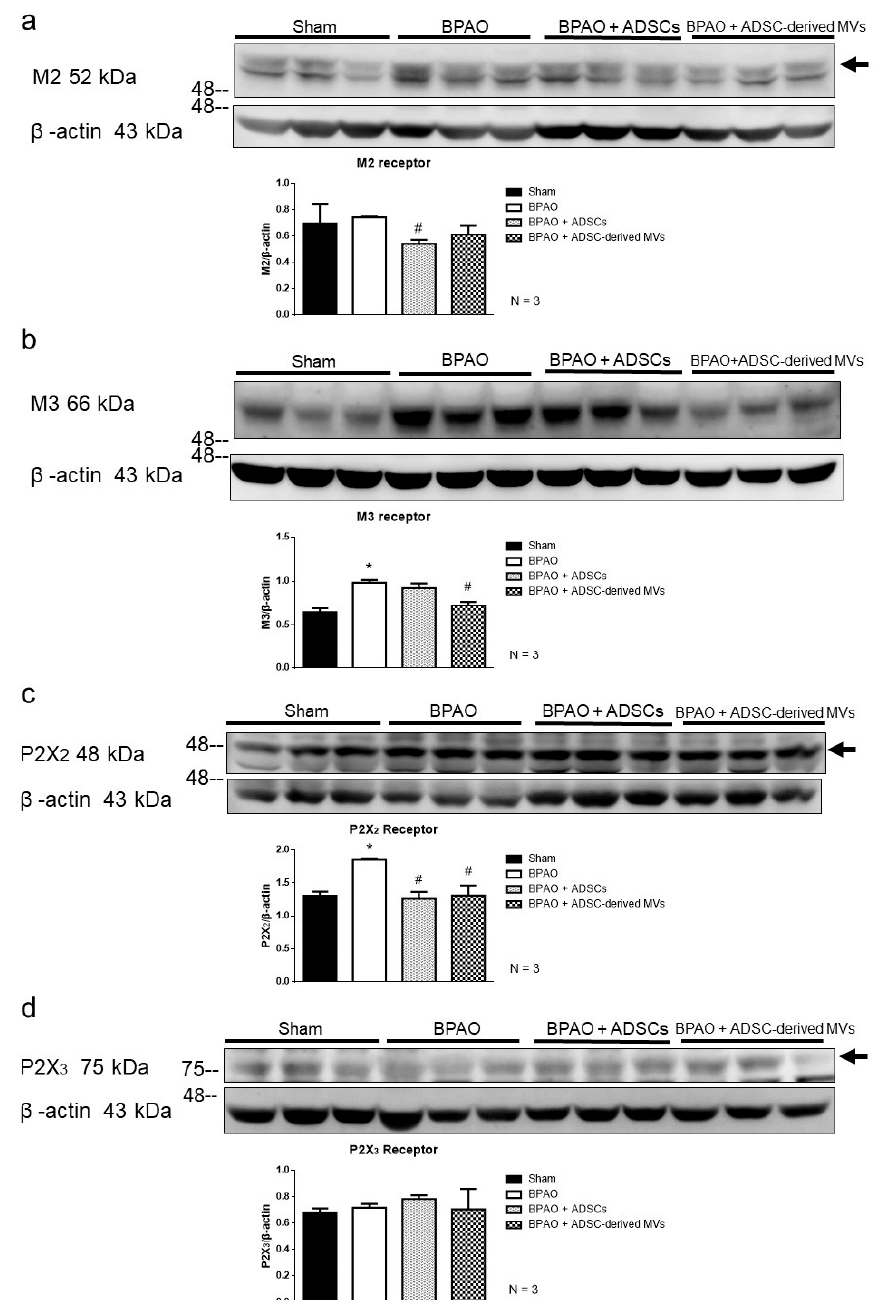
Figure 7. Purinergic and muscarinic signaling associated molecules changes on western blot study in separated group. Figure 7 showed the expression of muscarinic cholinergic (M2 and M3) and purinergic receptor proteins (P2X2 and P2X3) by Western blot. In the top panel, ( a ) showed the expression of M2 receptor is significantly decreased in BPAO + ADSCs group compared to BAPO group ( # p < 0.05). The expression of M2 receptor had trend of decreasing in BPAO + ADSC-derived MVs group compared to BAPO group without significant differences ( p > 0.05). In the middle panel, ( b ) showed that the expression of M3 receptor was significantly increased in BPAO group compared to sham group (* p < 0.05). The expression of M3 receptor is significantly decreased in BPAO + ADSC-derived MVs group compared to BAPO group ( # p < 0.05). ( c ) showed the expression of P2X2 receptors was significantly increased in BPAO group compared to sham group (* p < 0.05). The expression of P2X2 receptor is significantly decreased in BPAO + ADSC-derived MVs and BAPO + MVs group compared to BAPO group ( # p < 0.05). In the bottom panel, ( d ) showed the expression of P2X3 receptor is of no significant differences between